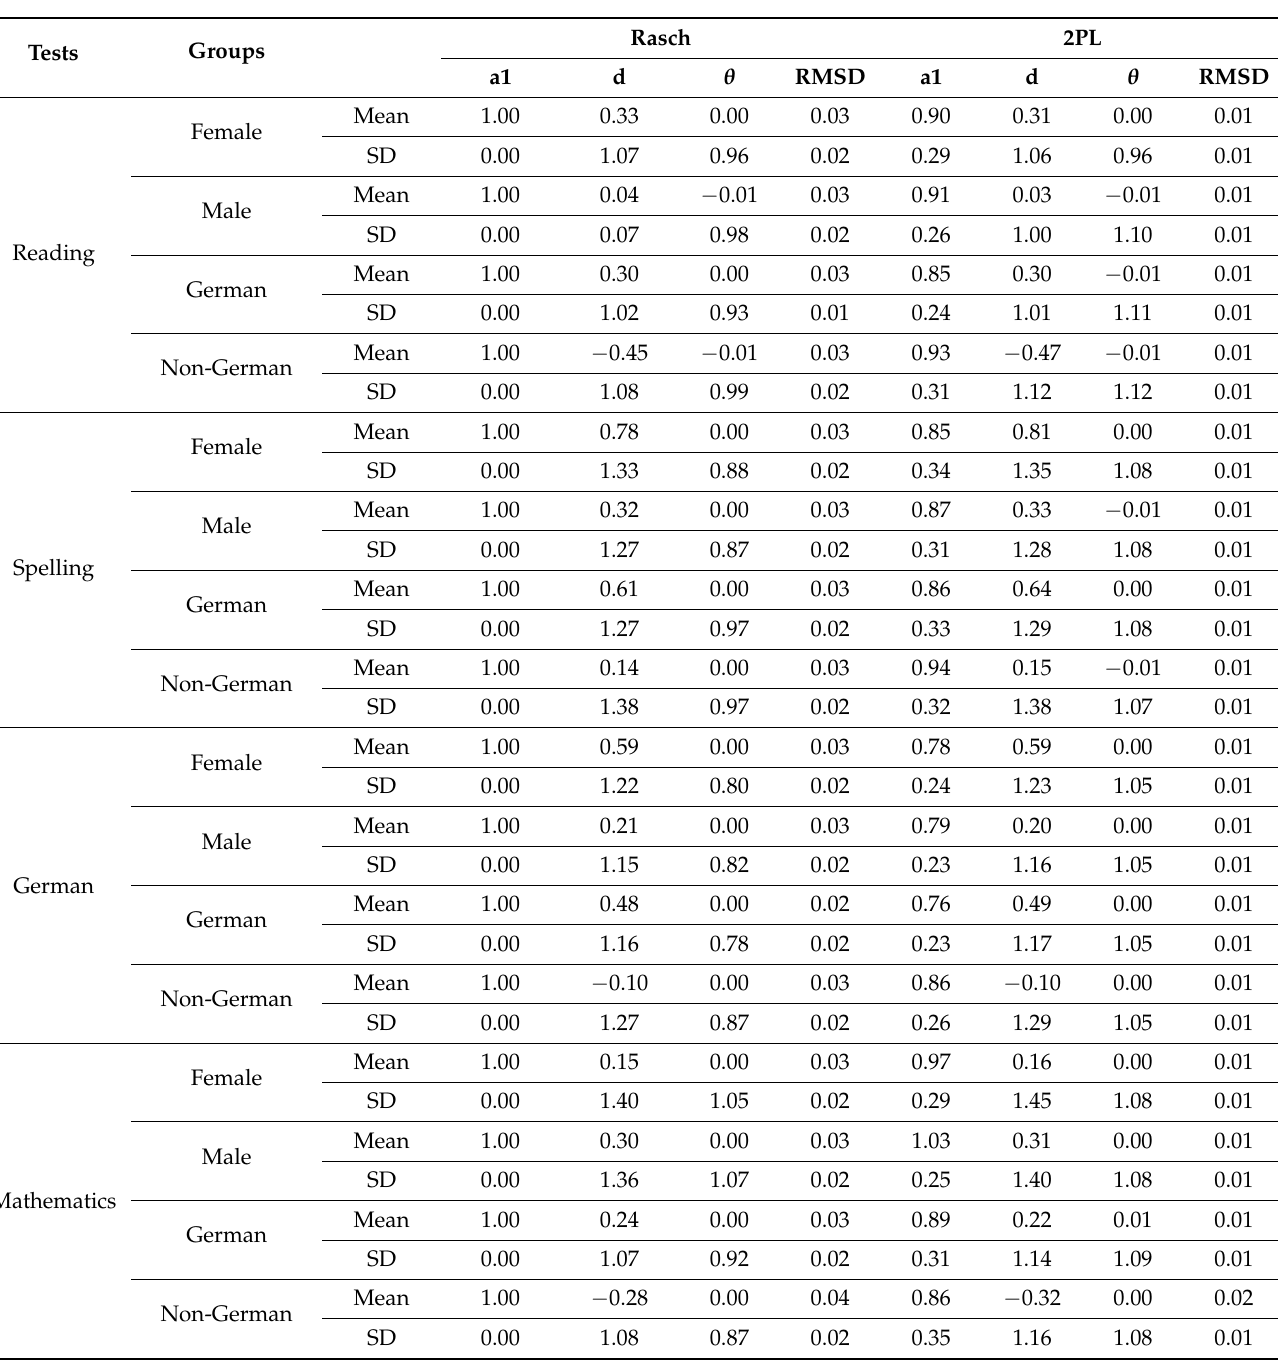
Table 4. Results of means and standard deviations of item parameters, abilities, and RMSD values for each